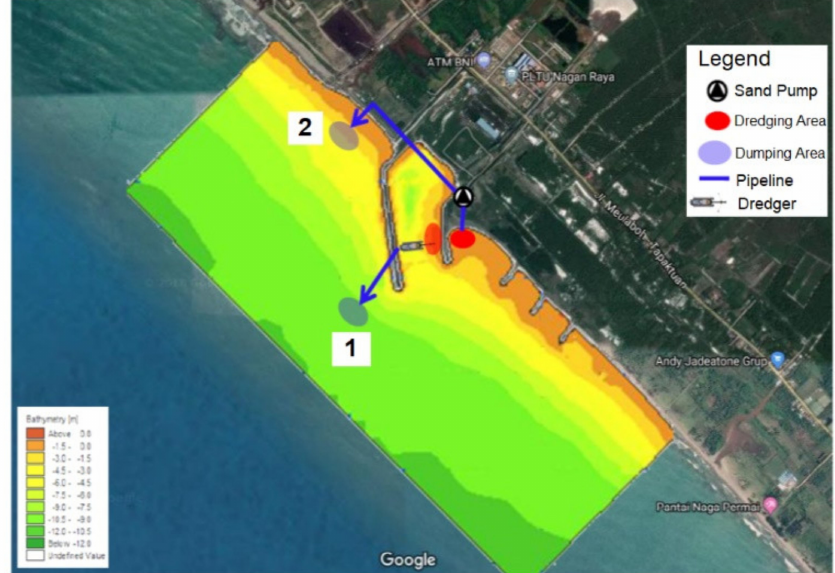
Figure 13. Dredging and dumping location.